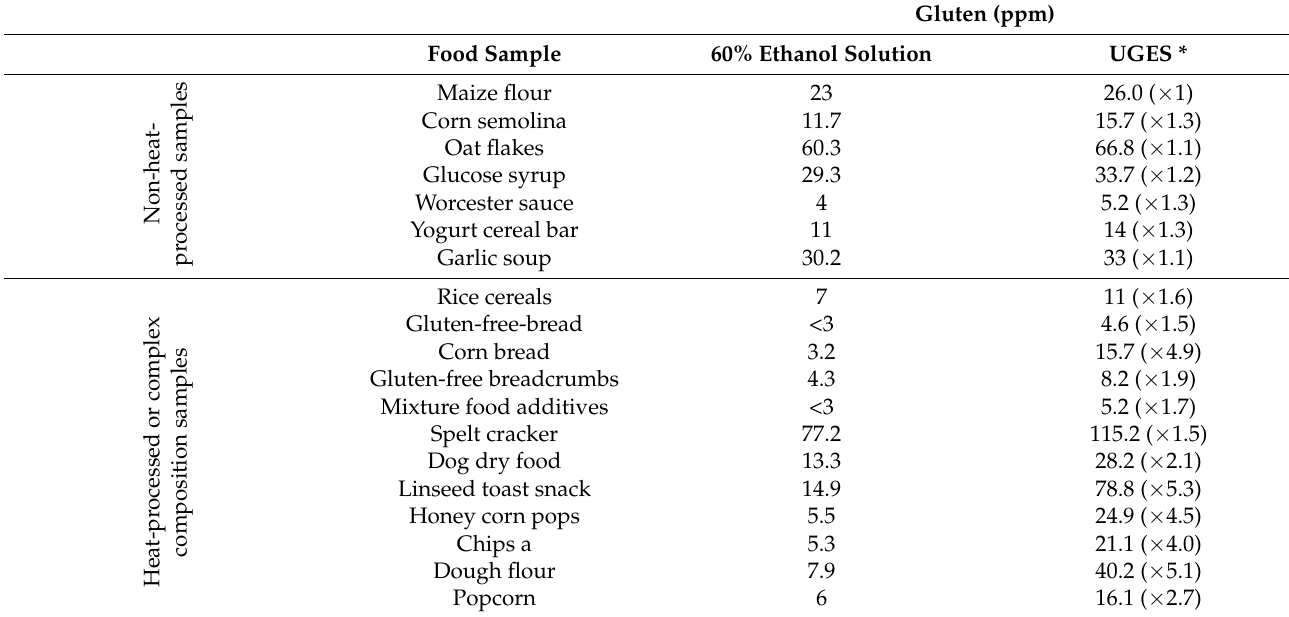
Table 2. Gluten content in ppm (mg/kg) of different samples by sandwich ELISA with 60% ethanol and Universal Gluten Extraction Solution